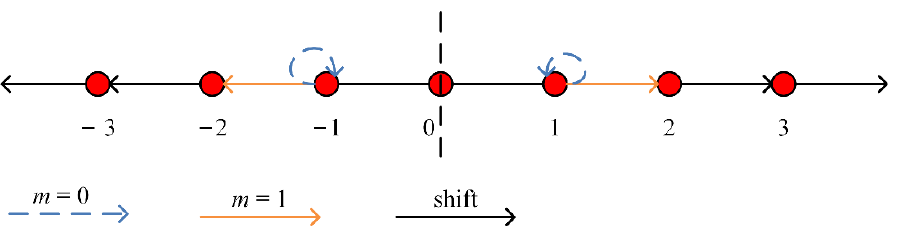
Figure 1. Origin-symmetric histogram shifting.